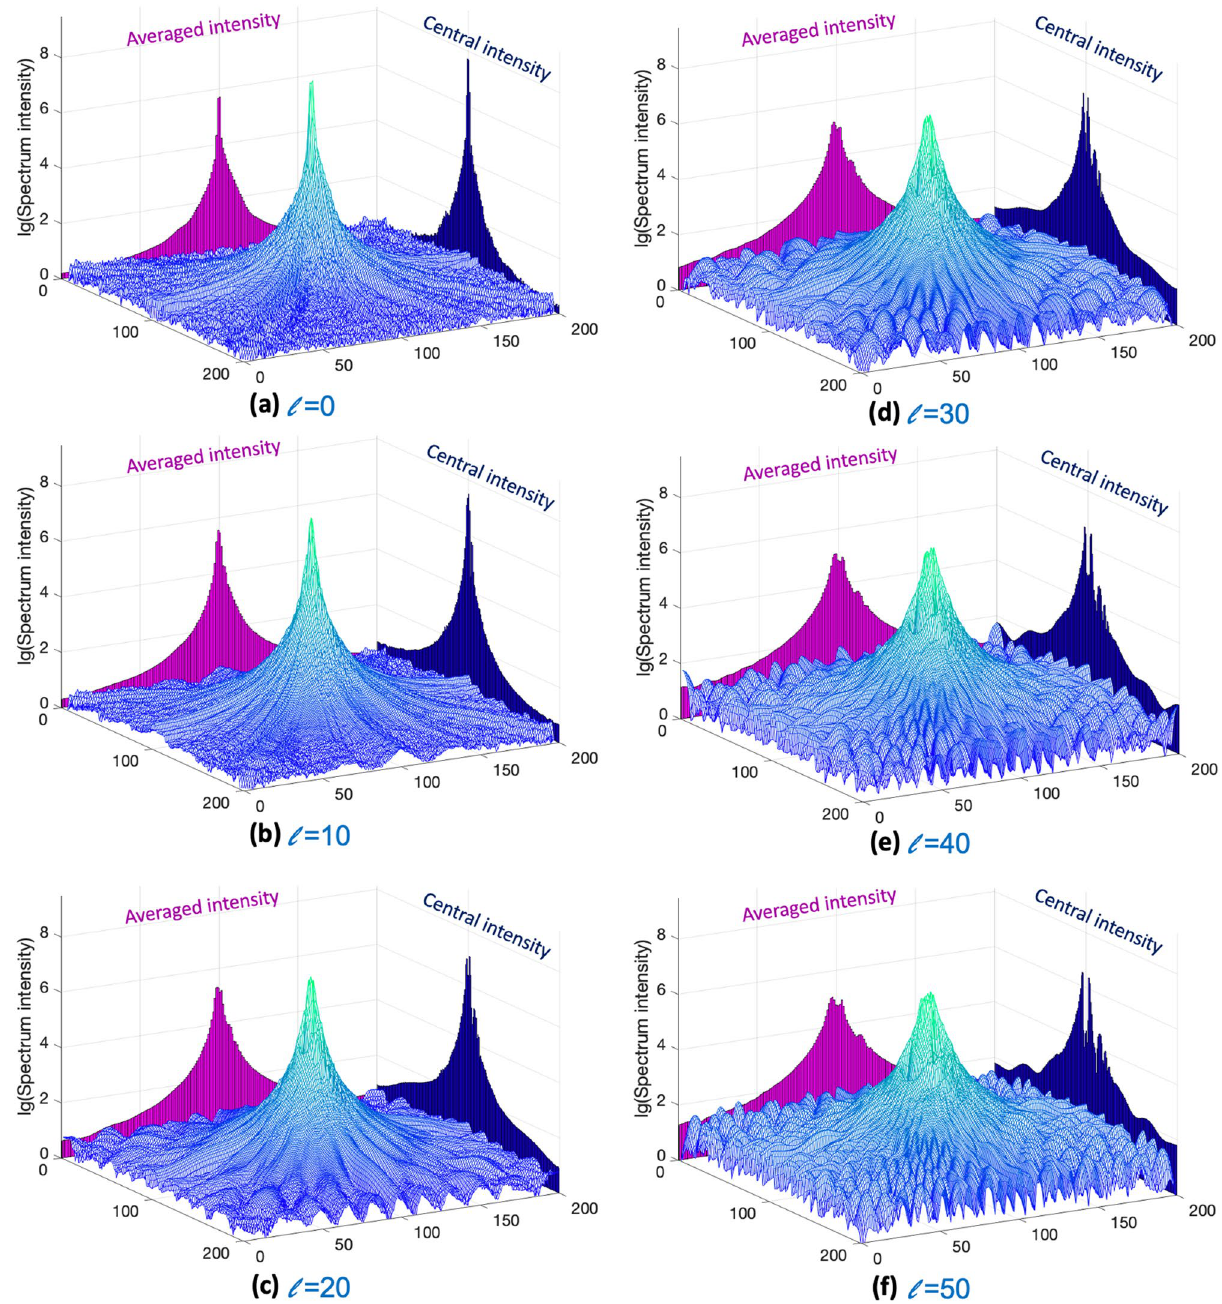
Figure 3. 3D profile of the logarithmic intensity values of the modulated spectrum with topological charge l from 0 to 50 at an interval of 10. The averaged intensity is the averaged value along the line. The central intensity is the intensity value along the central line. (a) l = 0; (b) l = 10; (c) l = 20; (d) l = 30; (e) l = 40; (f) l = In this simulation, six pairs of constraints are utilized to obtain better iteration convergence. The intensity constraints with varying modulations should be different to introduce the uncorrelated terms. Multiple vortex phases are generated with different topological charges. Scanning in the radical direction is performed in the spectrum intensities. Pixels engaged to record the spectrum intensities are significantly different before and after the modulation. Figure 6 presents the reconstructions when the iteration number is from 0 to 1000. With topological con- straints and intensity constraints, the calculation starts to converge as the iteration number is increased. After 20 iterations, the outline of the phase can be distinguished. After 70 iterations, the artifacts on the phase are elimi- nated. As the iteration number is increased from 70 to 600, the RMSE decreases. The RMSE fluctuates slightly at the period of six iterations because the number of constraints was also six. Finally, the calculation enters the final stage when the iteration number is above 600. The reconstruction of the complex-amplitude object reaches